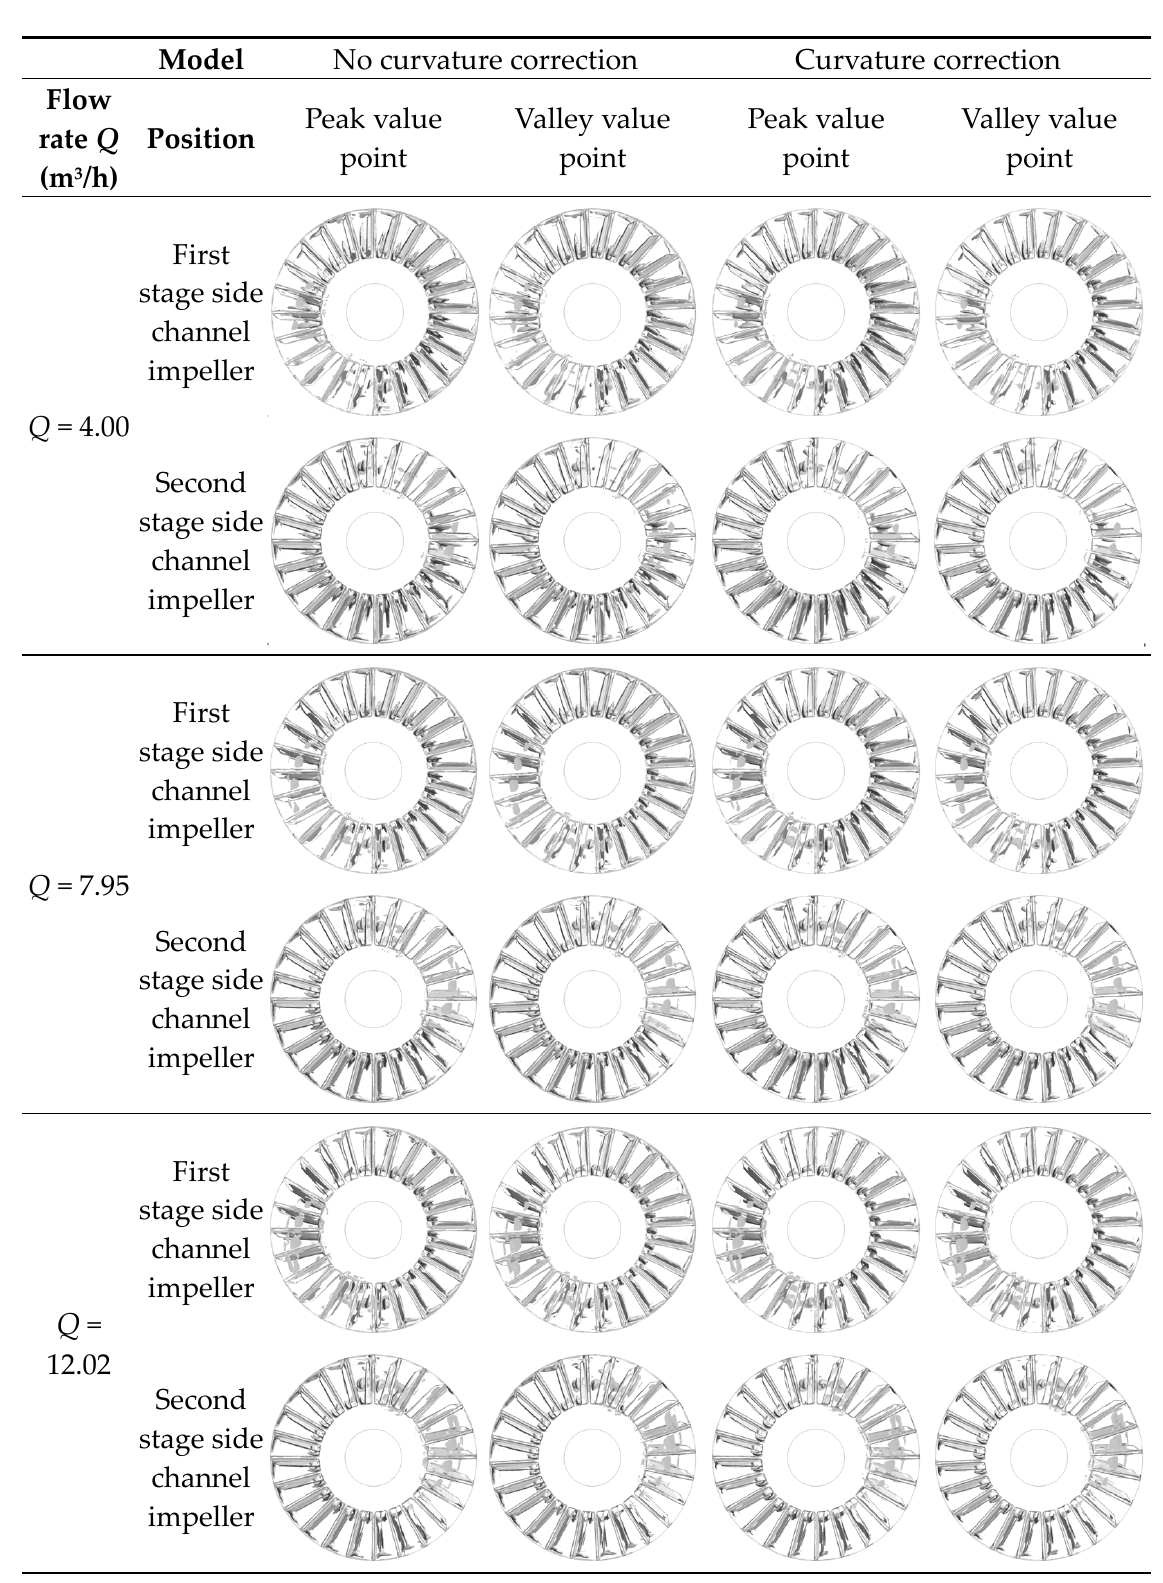
Figure 16. Distribution of vortex core area of side channel impeller based on the DES model, with or without curvature correction at the peak and valley points of the head (instantaneous).